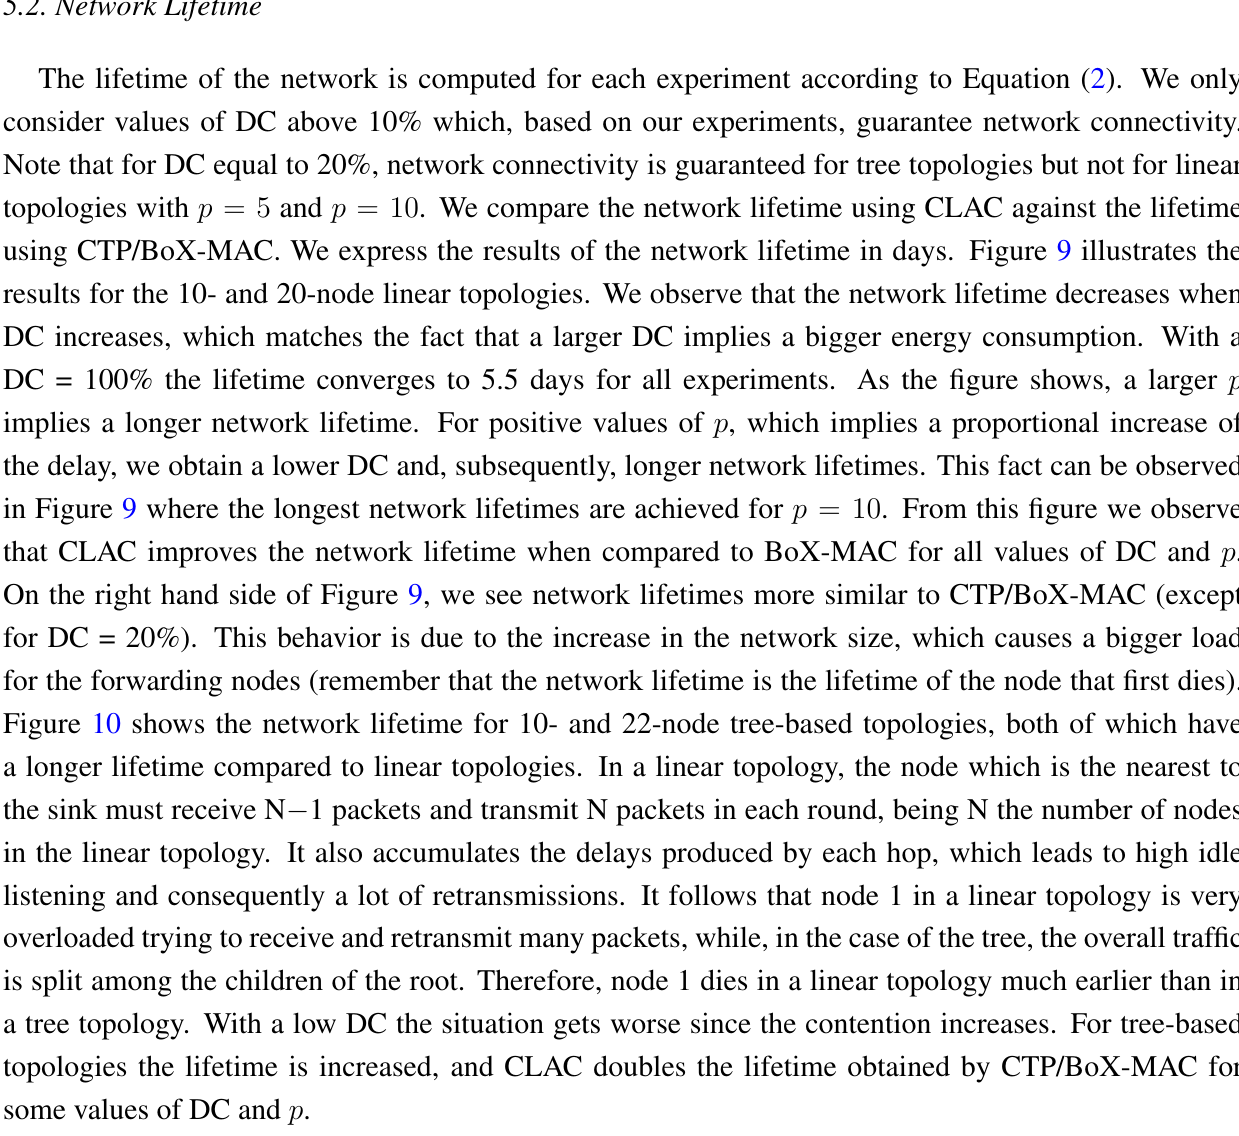
Figure 9. Network lifetime (in days) for 10-node (left) and 20-node (right) linear